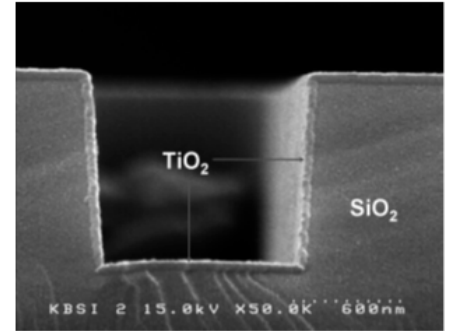
Figure 8. Cross-sectional SEM image of a TiO 2 thin film obtained using PEALD on a patterned SiO 2 / Si surface maintained at 200 °C. Reprinted from Park et al. [67]. Copyright © 2004 Taylor & Francis Group.